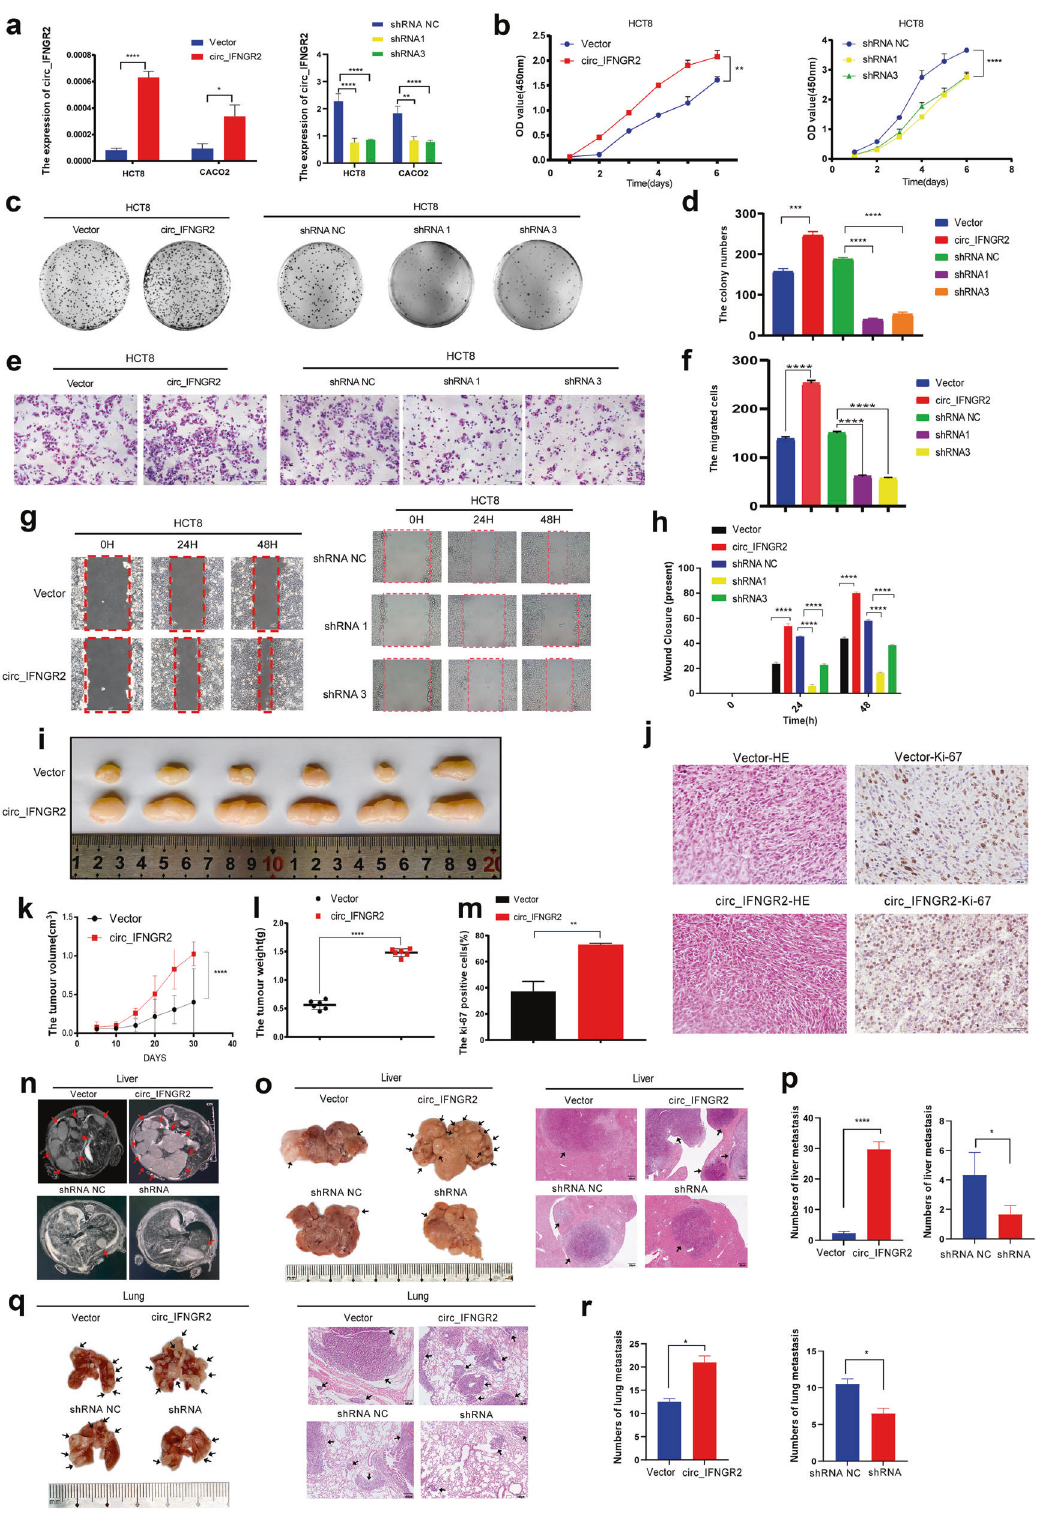
were also successfully expressed in above cell lines (Fig. 2a, left). The following cell function assays revealed the in fl uence of circIFNGR2 on CRC cells. CCK8 (Fig. 2b) and colony formation (Fig. 2c, d) assays showed overexpression of circIFNGR2 increased proliferation ability of HCT8 cells, while inhibition